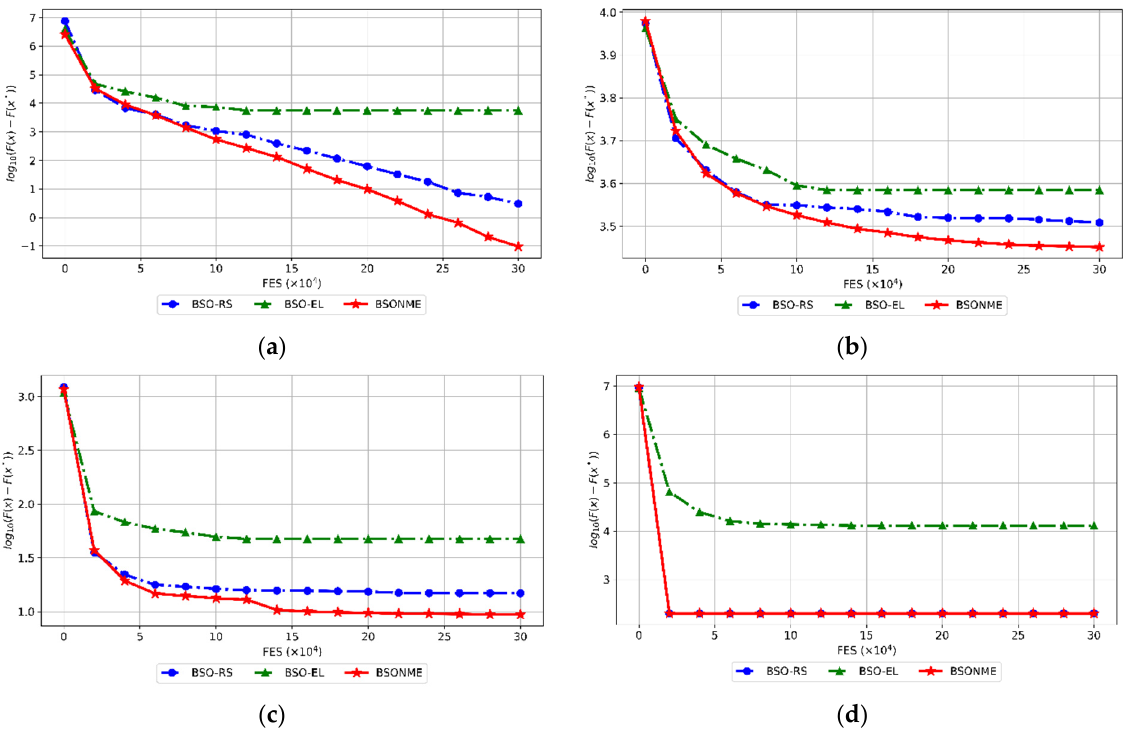
Figure 10. Effectiveness verification of elite learning mechanism and reinitialization strategy. ( a ) F 3 ; ( b ) F 11 ; ( c ) F 19 ; ( d ) F 30 . ( b ) F 11 ; ( c ) F 19 ; ( d ) F 30